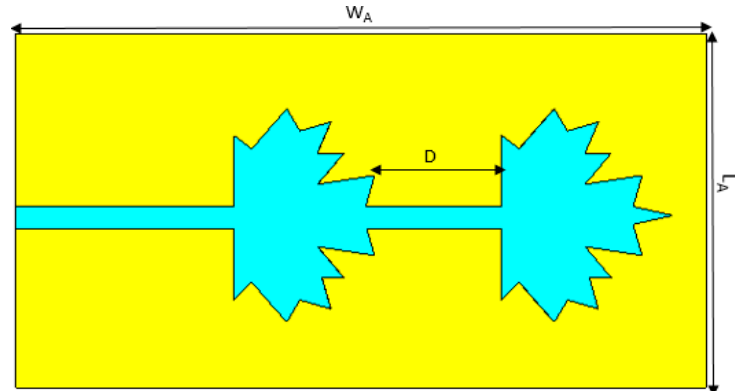
Figure 12. Front view for the 2 × 1 antenna array.